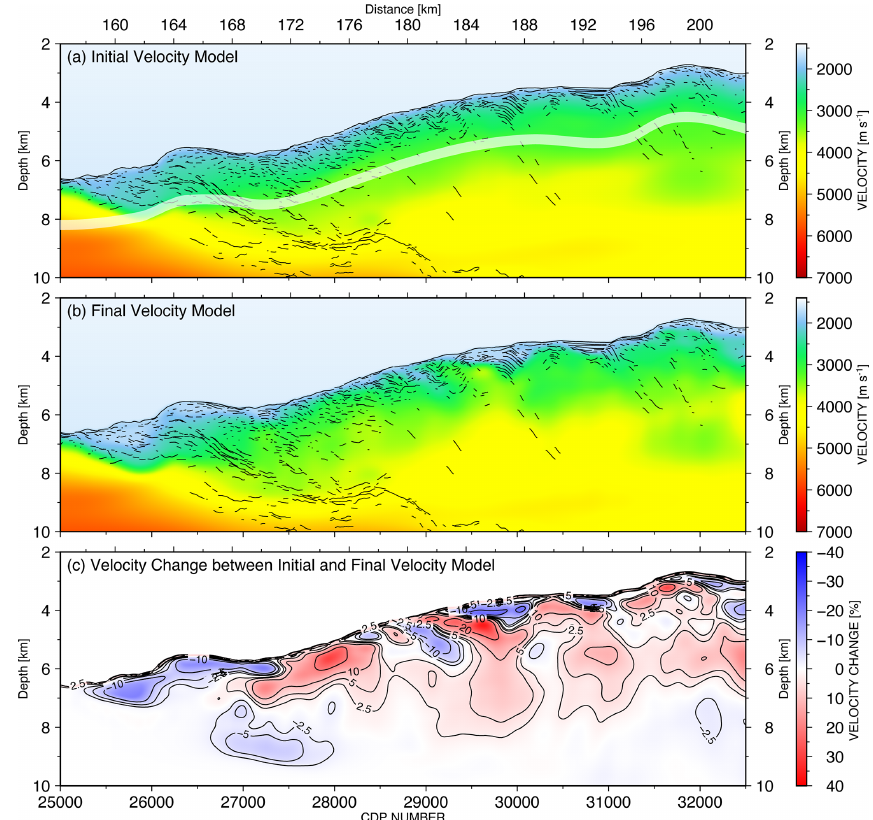
Figure 14. (a) The initial velocity model merged with the wide-angle velocity model (below the white transparent band). The line drawing is based on the final PSDM image. (b) The final velocity model calculated from five iterations of the ray-based tomographic velocity inversion. (c) The velocity change in percentage from the initial to the final